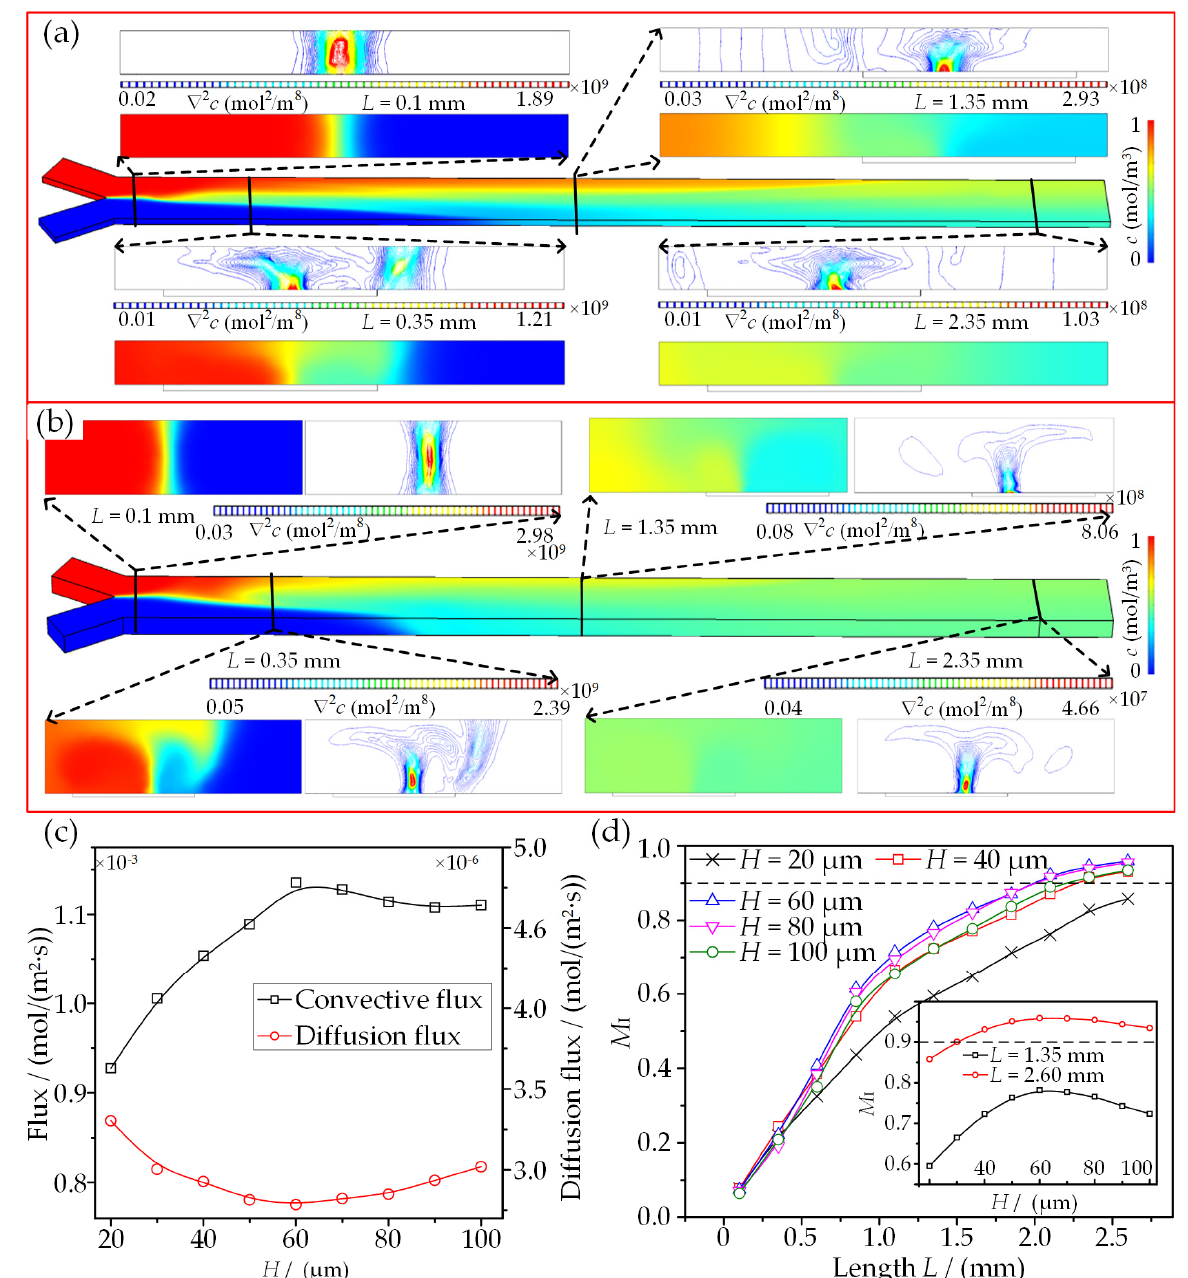
Figure 4. Comparison of mixing performance among different channel heights at A = 10 V and f = 100 Hz. ( a , b ) Concentration distribution and the corresponding concentration gradient at H = 20 µm and 60 µm. ( c ) Flux variations between two fluids. ( d ) Mixing efficiency vs. the mixing length under different channel heights H .